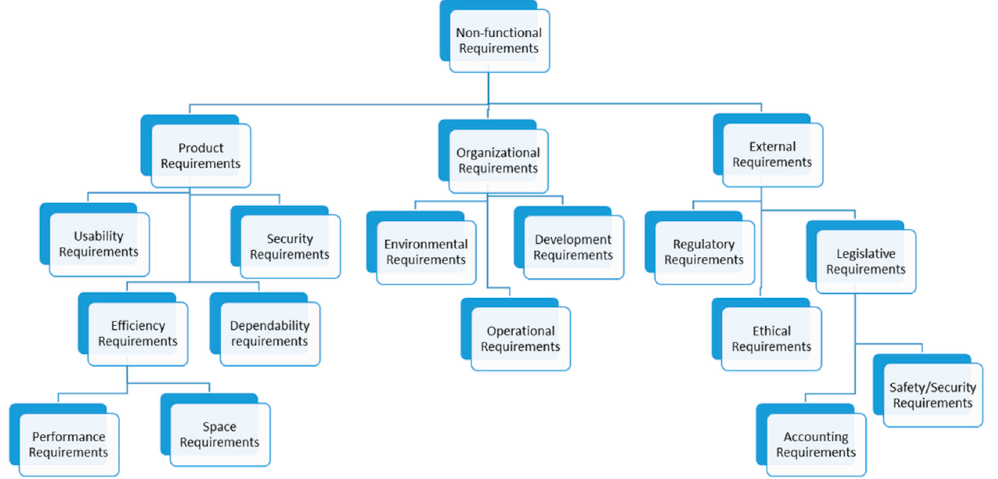
Figure 1. Non-Functional Requirement Categories, based on [10].